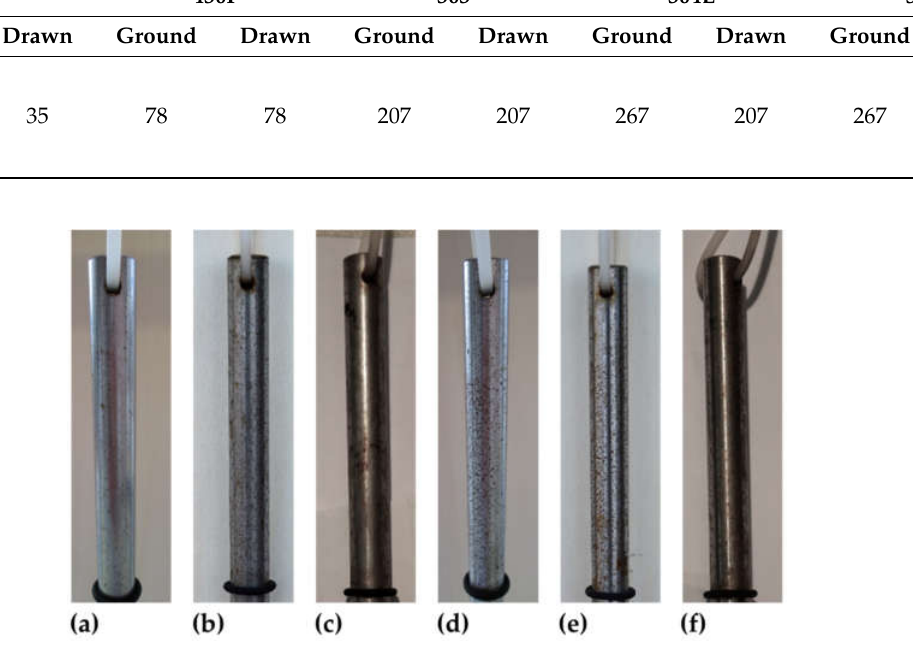
Figure 5. AISI 430F sample exposed to marine atmosphere after ( a ) 80 days—drawn finishing; ( b ) 210 days—drawn finishing; ( c ) 270 days—drawn finishing; ( d ) 80 days—ground finishing; ( e ) 210 days—ground finishing; and ( f ) 270 days—ground finishing.